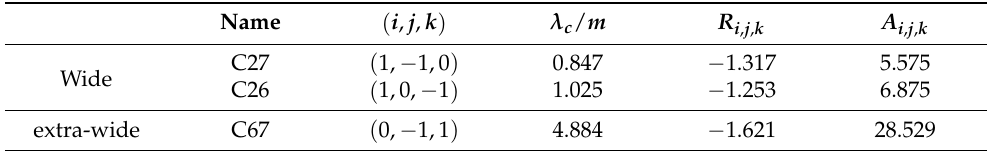
Table 2. Wide-lane combination of